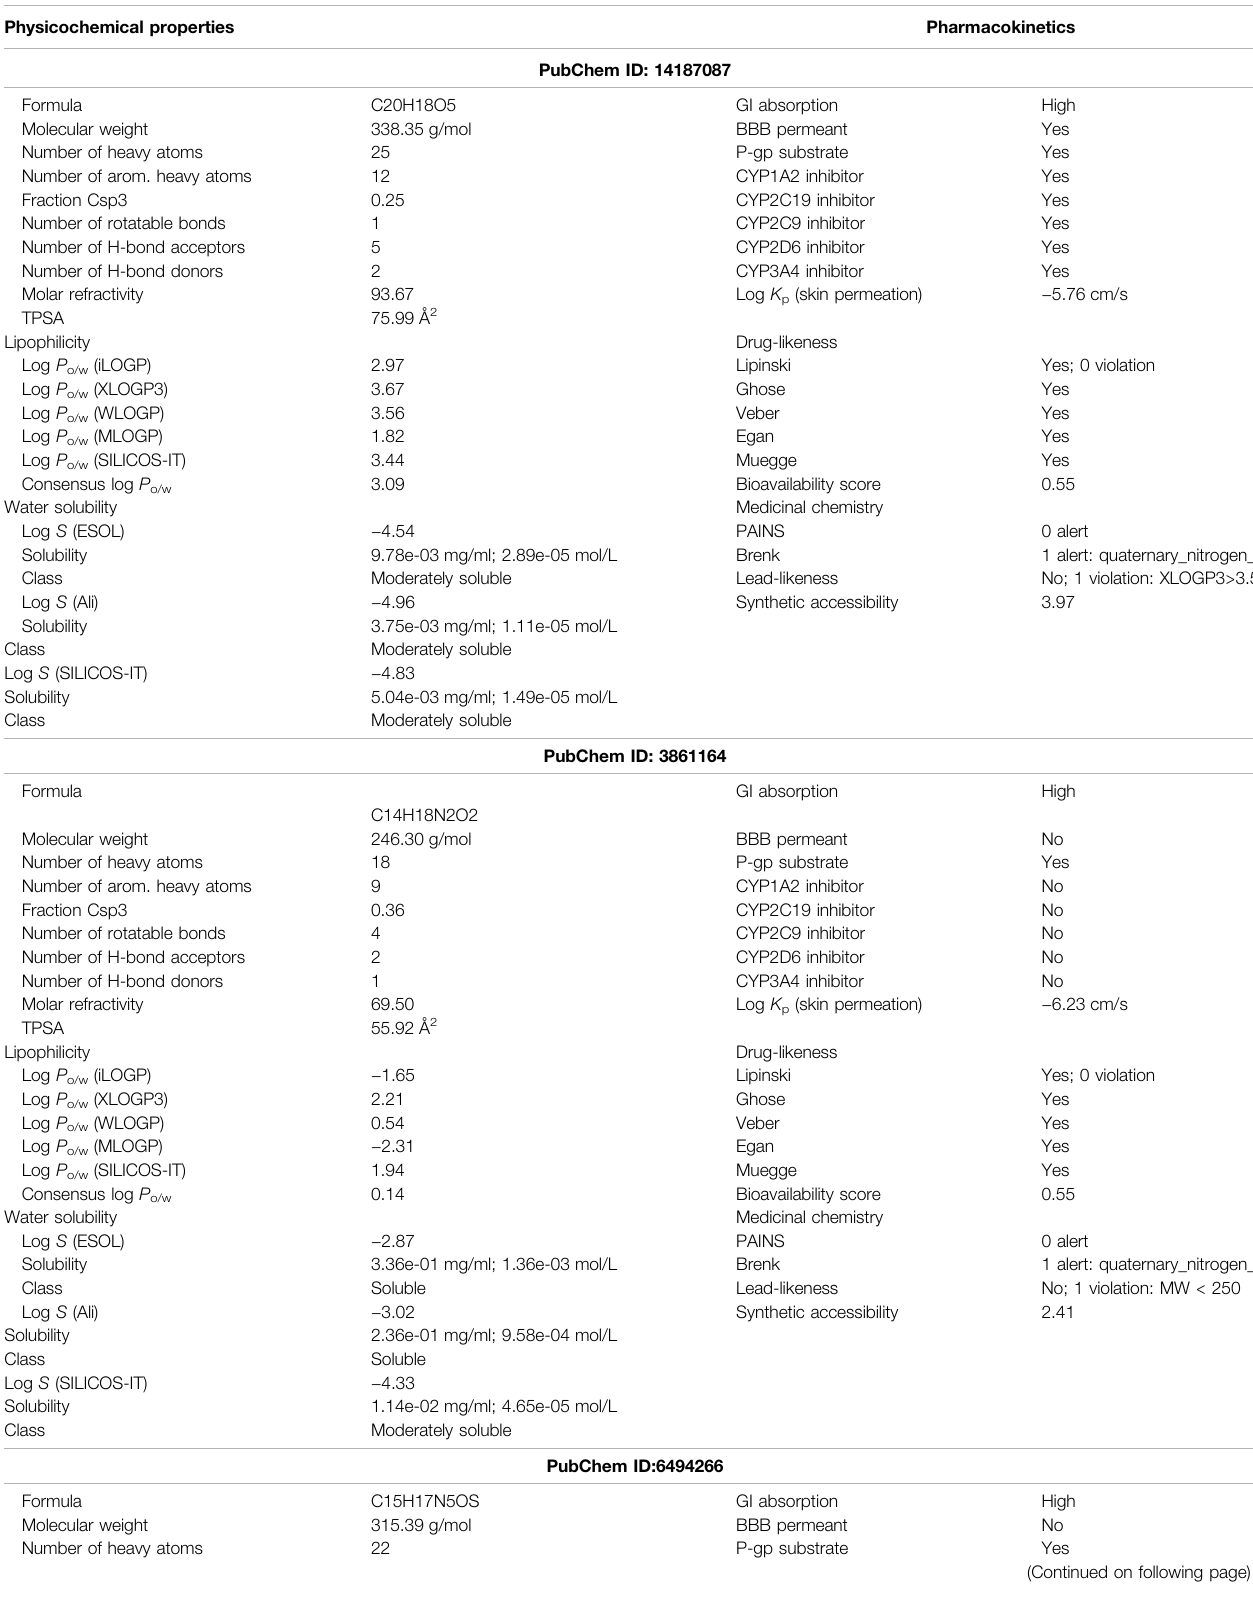
TABLE 3 | Overview of different physicochemical properties, pharmacokinetics, medicinal chemistry, and drug-likeness of the